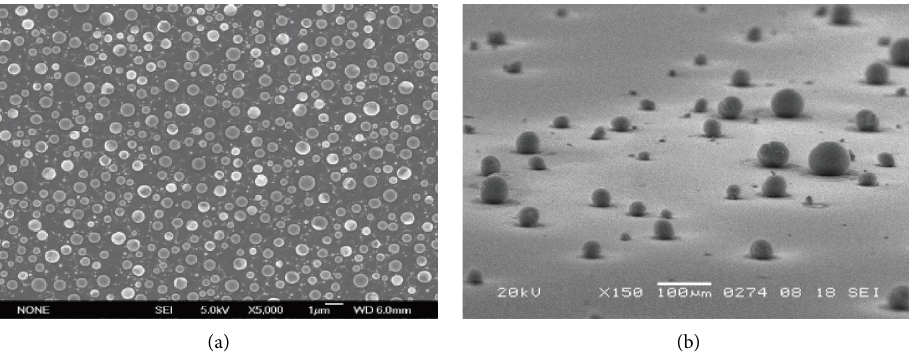
Figure 13: SEM image of liquid-phase Sn-droplets on a silicon wafer [45] (a) and (b), the nonwet substrate ( θ > 90 ° ).